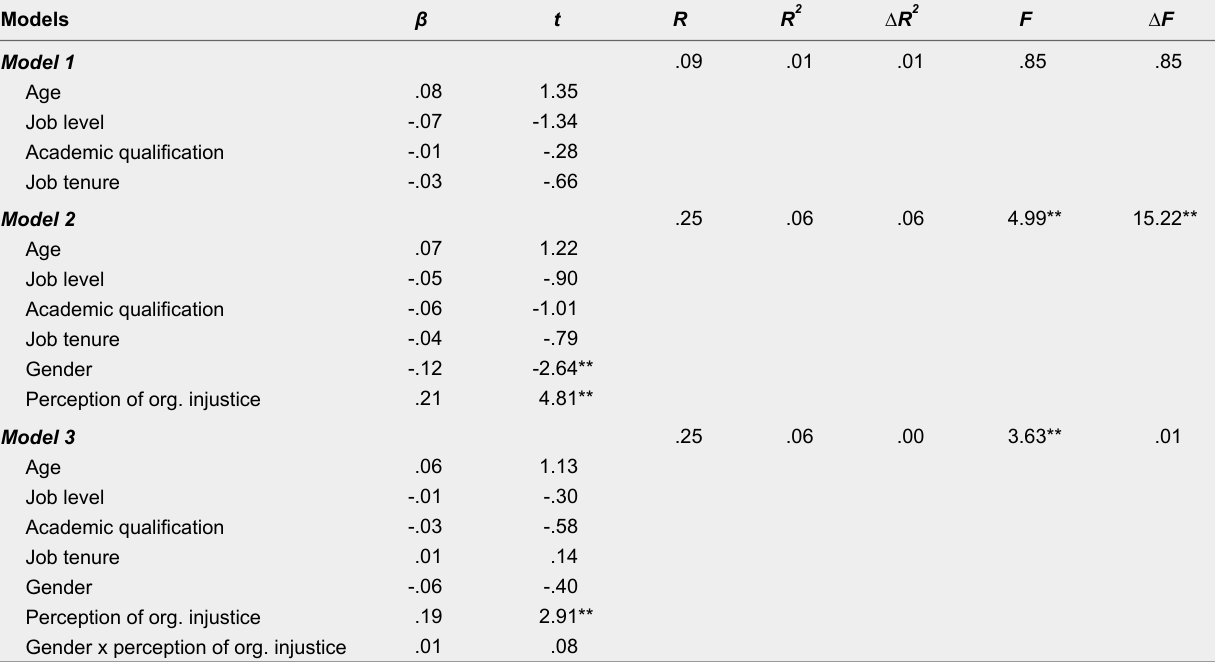
Hierarchical Multiple Regression on Interpersonal Violence